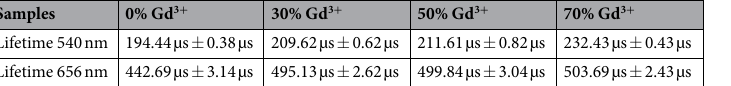
Table 1. Photoluminescence lifetimes of green emission (540 nm) and red emission (656 nm) for NaYF 4 samples, with different Gd 3 + molar concentration.